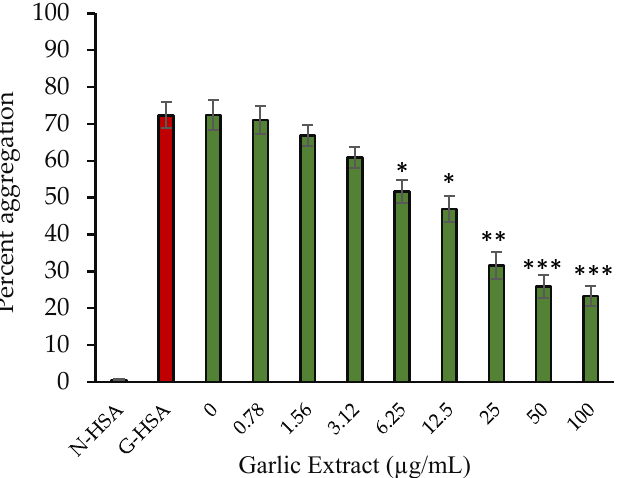
Figure 5. Percentage aggregation vs. concentration of garlic extract. Native HSA and G-HSA were incubated for 10 weeks and served as negative and positive controls, respectively. G-HSA was in- cubated with various concentrations (0–100 µg/mL) of garlic extract (green). The results are pre- sented as means ± SEM ( n = 3). All the percentage inhibition of protein aggregation results (0.78–100 µg/mL garlic extract) were compared with G-HSA sample. Comparison between two groups was performed based on t test, and significance was defined as * p < 0.05, ** p < 0.01, *** p < 0.001.